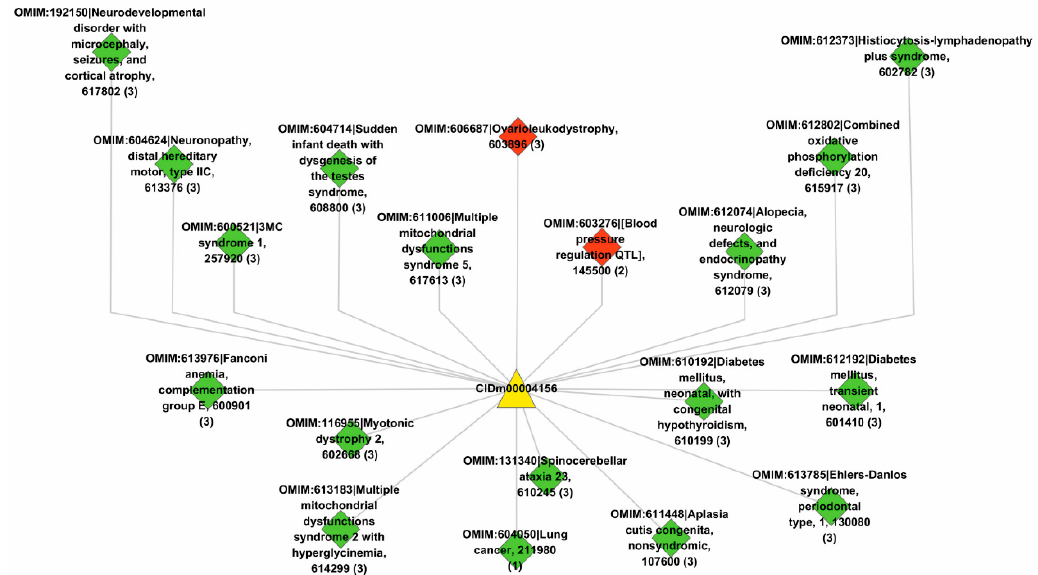
Figure 6. The disease phenotypes associated with drug CIDm00004156 via the predicted novel target genes. The diamond nodes in green denote phenotypes associated via at least one disease gene and the diamond nodes in red denote phenotypes associated via all the disease genes. The triangle node in yellow denotes the concerned drug CIDm00004156.